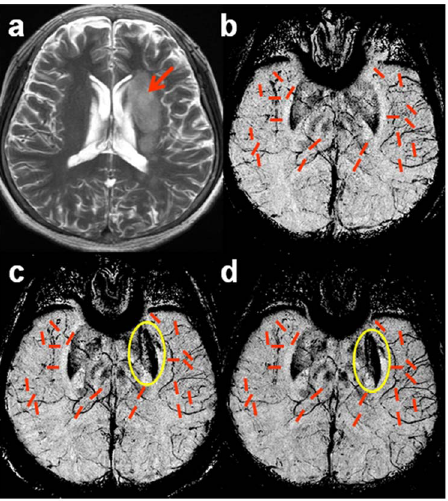
Figure 2. Vessel selection for a stroke patient. a) maximum intensity projection over 3 slices of T 2 weighted imaging shows stroke affected area (red arrow). b), c) and d) minimum intensity projections over 20 slices of SWI processed phase images showing the locations of the 10 measured vessels (red lines) for each hemisphere at (b) , 24 hours, (c) 2 to 3 weeks after stroke, and (d) 2 months after the onset of stroke. SWI shows hypointense signal on the stroke side of the brain (c,d), and also a hemorrhage (yellow circle) in the left putamen in the second and third scans (c,d).